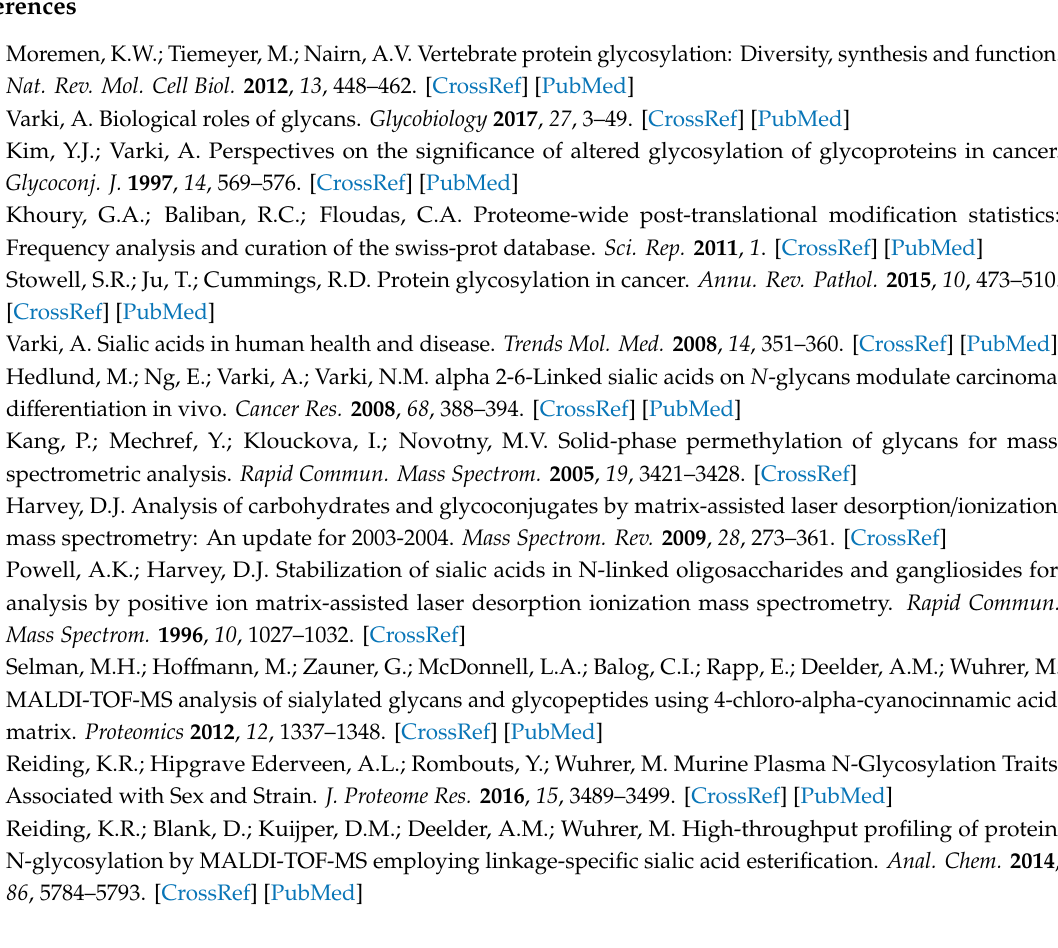
Supplementary Materials: The following are available online, Table S1: Information on physico-chemical characteristics, toxicity and availability of the used catalysts; Table S2: Linkage-specificity of catalysts by using sialyllactose standards; Table S3: Signal-to-Noise ratios (S / N) for each tested reaction condition; Table S4: List and overview of detected glycans using 6-Cl-HOBt at native conditions; Table S5: Evaluating the linkage-specificity of the reactions using the catalysts for complex samples; Table S6: Calibration masses list for sialyllactose standards; Table S7: Calibration masses list for total plasma released N -glycome; Figure S1: MALDI-TOF-MS spectrum of amidated 2,6-sialyllactose standard when using Oxyma Pure as catalyst at native condition; Figure S2: Signal-to-Noise ratio of ethyl esterified, lactonized and unmodified ([M + Na] + and [M − H + 2Na] + ) reaction products on α 2,6 (A, B) and α 2,3-sialyllactose (C, D) at 60 (A, C) and 37 ◦ C (B, D) incubation.; Figure S3: Representative picture of an in-house prepared cotton-HILIC SPE